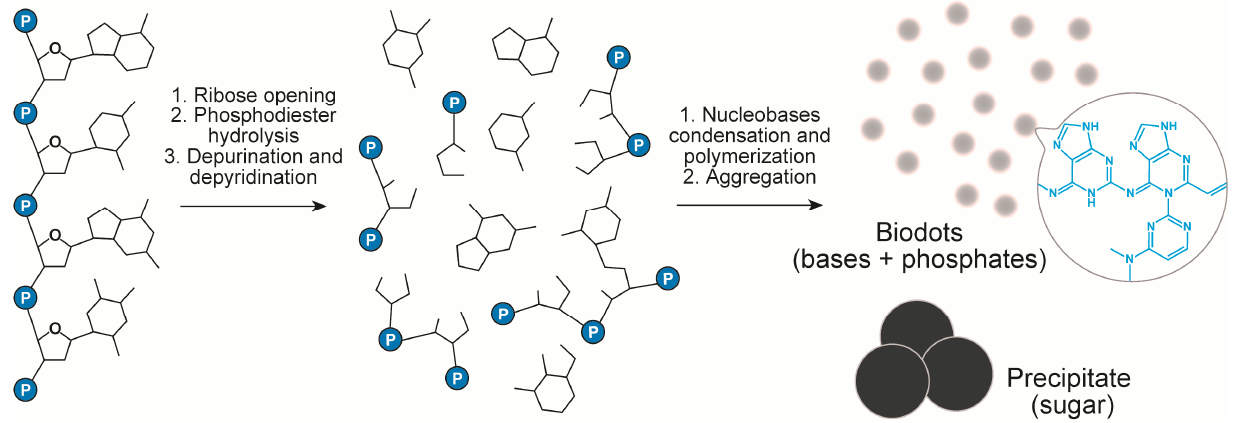
Figure 4. Chemical transformation of DNA during HT